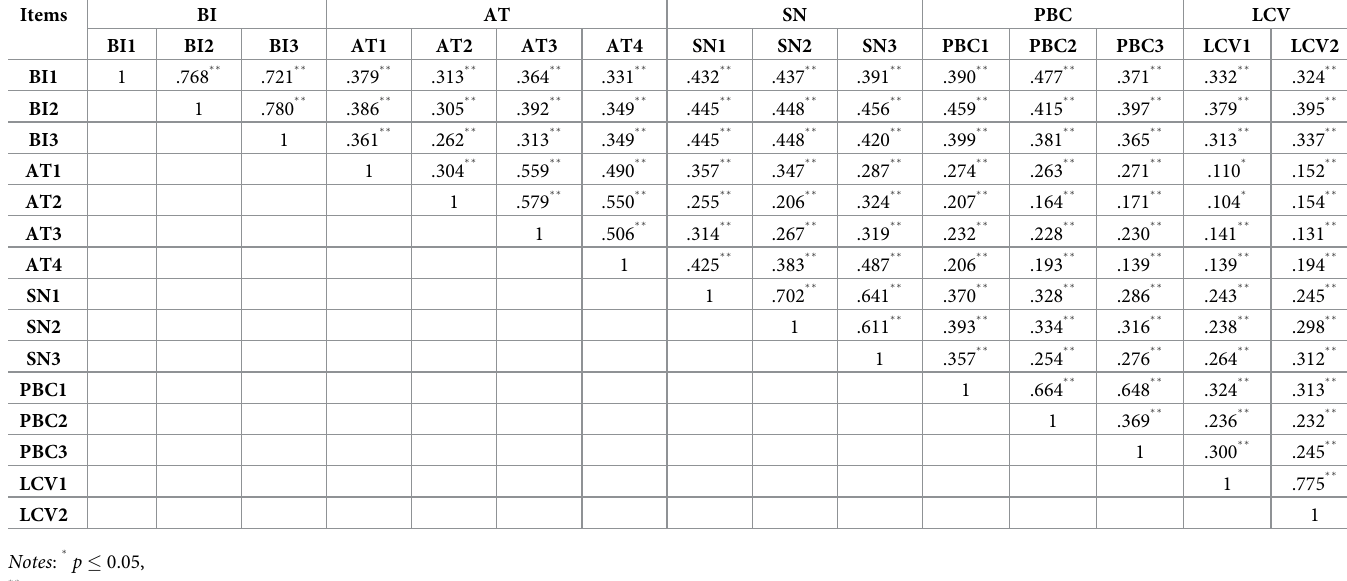
Table 6. Pearson correlations among items.